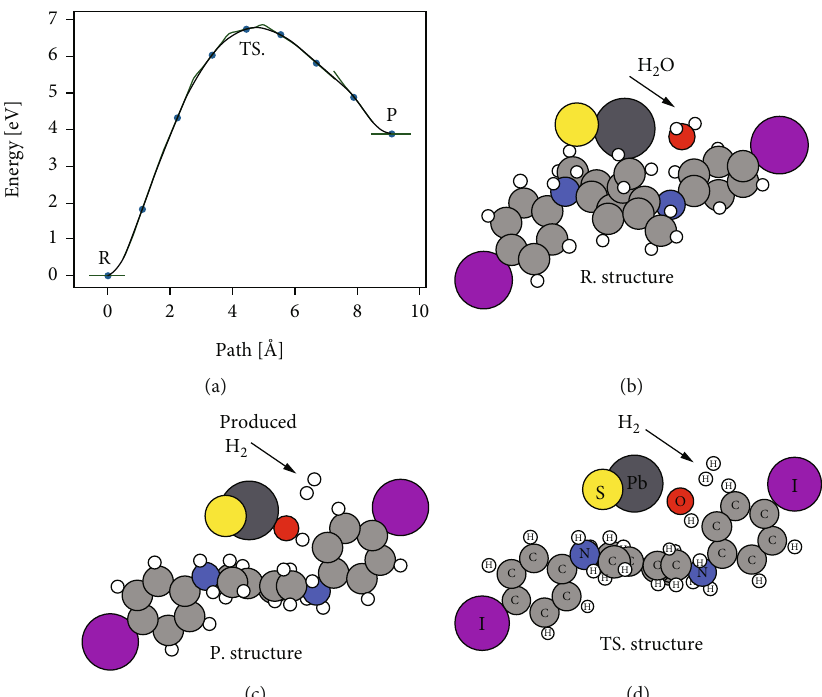
Figure 8: (a) The nudged elastic band (NEB) calculation of the energies along the reaction path towards hydrogen production. Δ E ~ 7 eV is the reaction path barrier. (b) The structure of the water and PANI/PbS reactants ( R ). (c) The product structure ( P ) after the splitting of the hydrogen. (d) The transition state structure (TS).